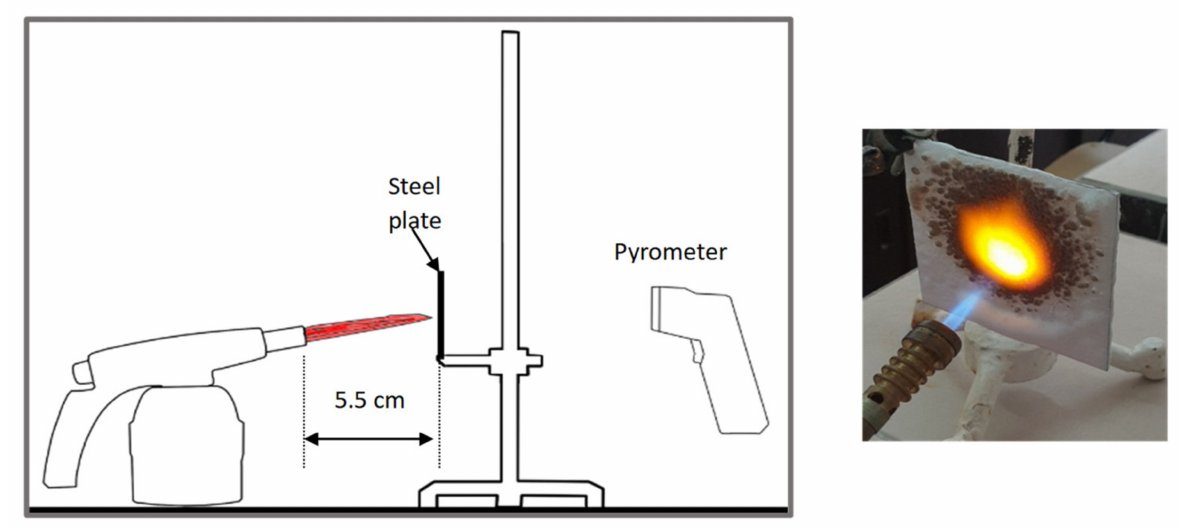
Figure 1. Fire test set